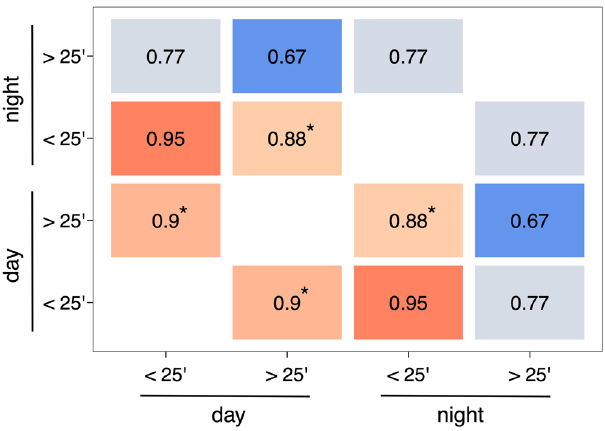
Fig. 2 Correlation matrix between social networks built on different times of the day (night or day) and across social contexts (interactions longer or shorter than 25 min). ‘ * ’ The permutation test is signi fi cant at the level